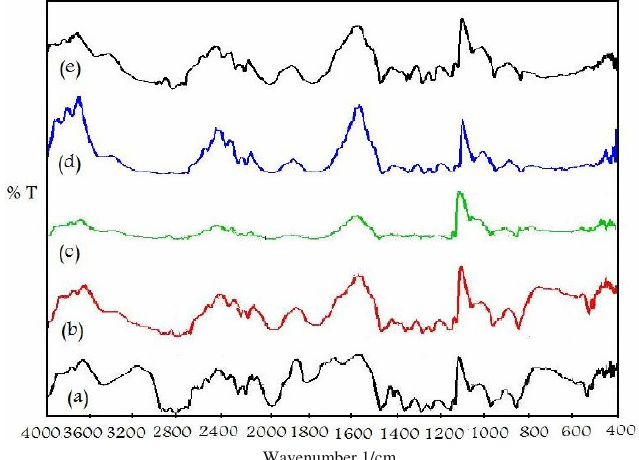
Figure 1. FTIR spectra of pure (a) PEG and complexes PEG–NH4Cl–X % TiO2; (b) 0%; (c) 5%; (d) 10%; (e)